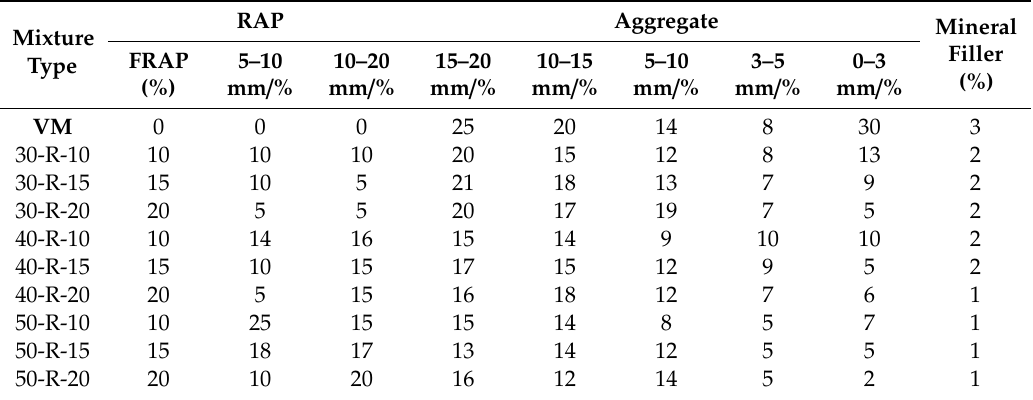
Table 7. Material composition ratios of mixtures containing various percentages of reclaimed asphalt pavement (RAP) and fine reclaimed asphalt pavement